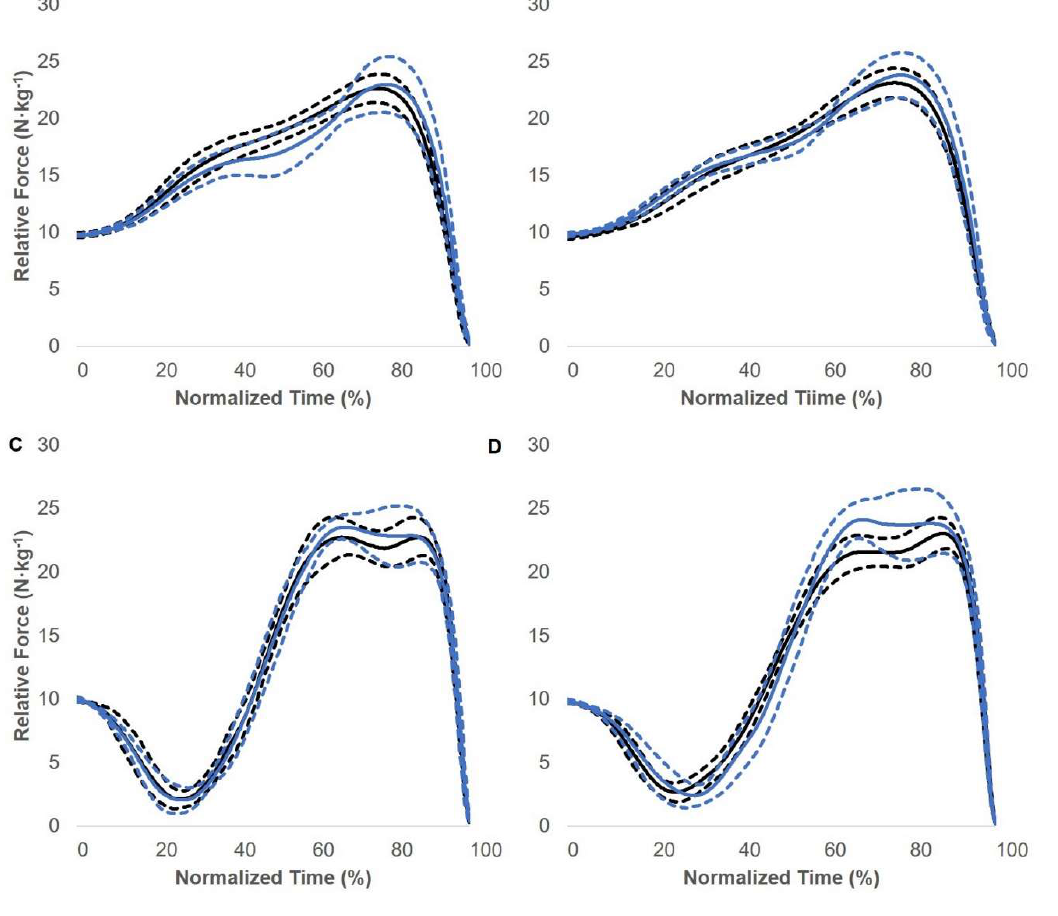
Figure 5. CATCH and PULL group squat jump and countermovement jump force–time curve adaptations. Pre- ( A ) and post-intervention ( B ) squat jump force–time curve adaptations. Pre- ( C ) and post-intervention ( D ) countermovement jump force–time curve adaptations. Solid and dashed lines display the group average and 95% confidence intervals, respectively.